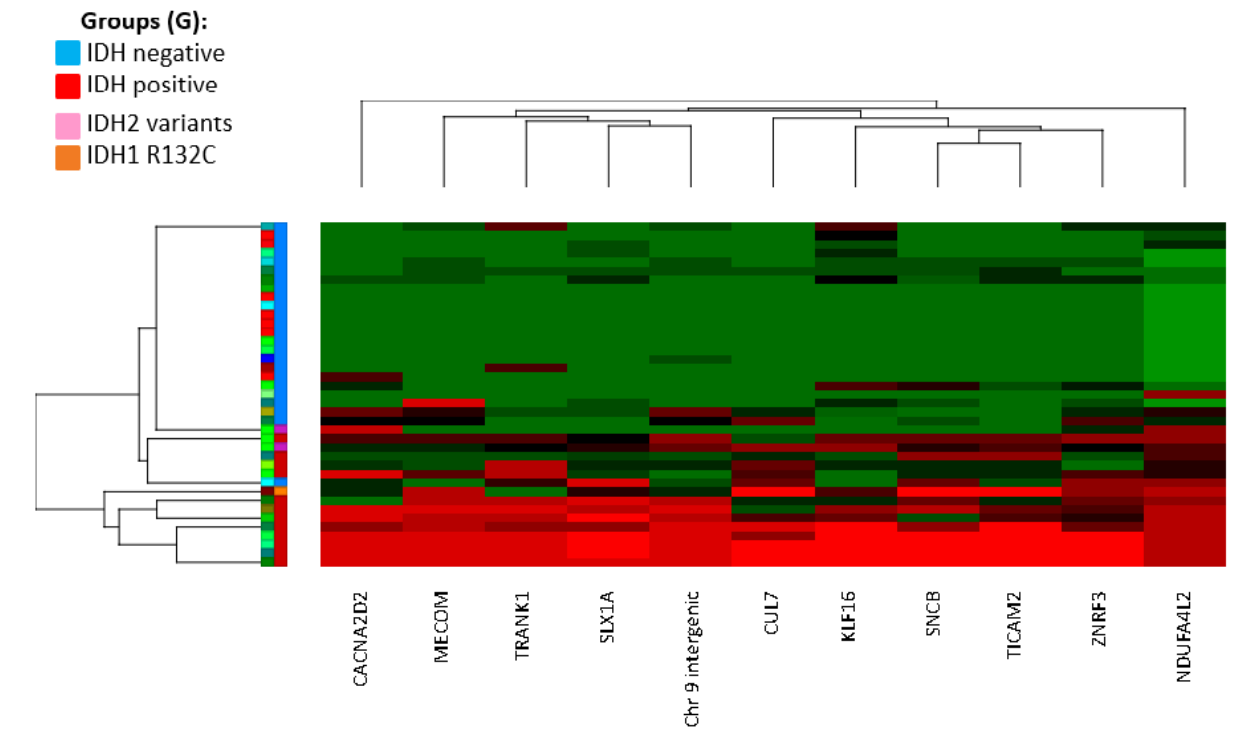
Figure 1. Hierarchical clustering of the top 11 CG sites (column) that were differentially methylated (epi-signature) in IDH-positive group versus IDH-negative group. Row; S: individual samples. G: group (blue: IDH-negative, red: IDH-positive, pink: IDH2 variants by NGS, orange: IDH1 variant by NGS). Table 1. CIMP epi-signature: top 11 CG sites that were differentially methylated in IDH-positive group versus IDH-negative group.